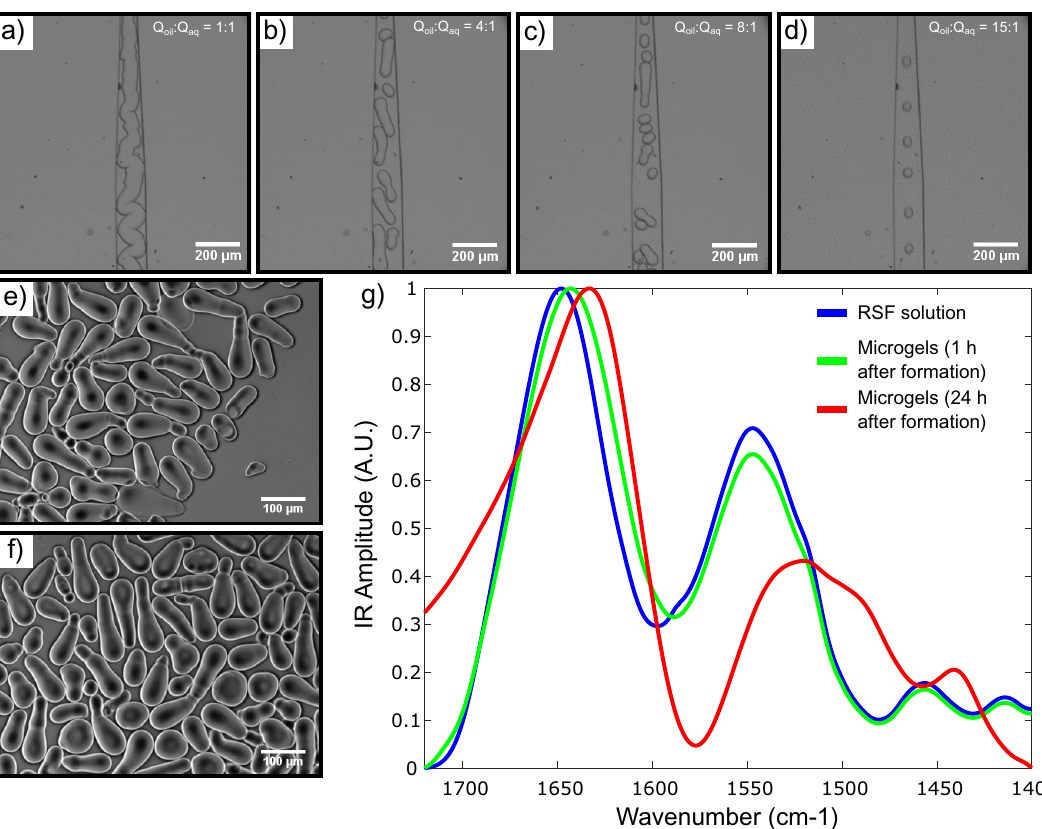
Figure 2. (a–d) Brightfield images showing the outlet of the microfluidic chip. A 40 mg/ml RSF protein was used as the dispersed phase and FC-40 with fluorosurfactant was used as the continuous phase. (a) Elongated fibre-like structure when Q dis = 100 µ L/h, Q cont = 100 µ L/h. (b) Asymmetric, tubular structures when Q dis = 100 µ L/h, Q cont = 400 µ L/h. (c) Mixture of tubular and spherical structures when Q dis = 100 µ L/h, Q cont = 800 µ L/h. (d) spherical structures when Q dis = 100 µ L/h, Q cont = 1500 µ L/h. (e) Darkfield images of tubular structures following formation. (f) Darkfield images of tubular structures one week after formation. (g) FTIR spectra of 40 mg/ml RSF. The blue curve represents the RSF solution at t = 0 h, before any gelation has occurred. The green curve represents the micro-gels 1 h after formation, while the red curve corresponds to the micro-gels 24 h after